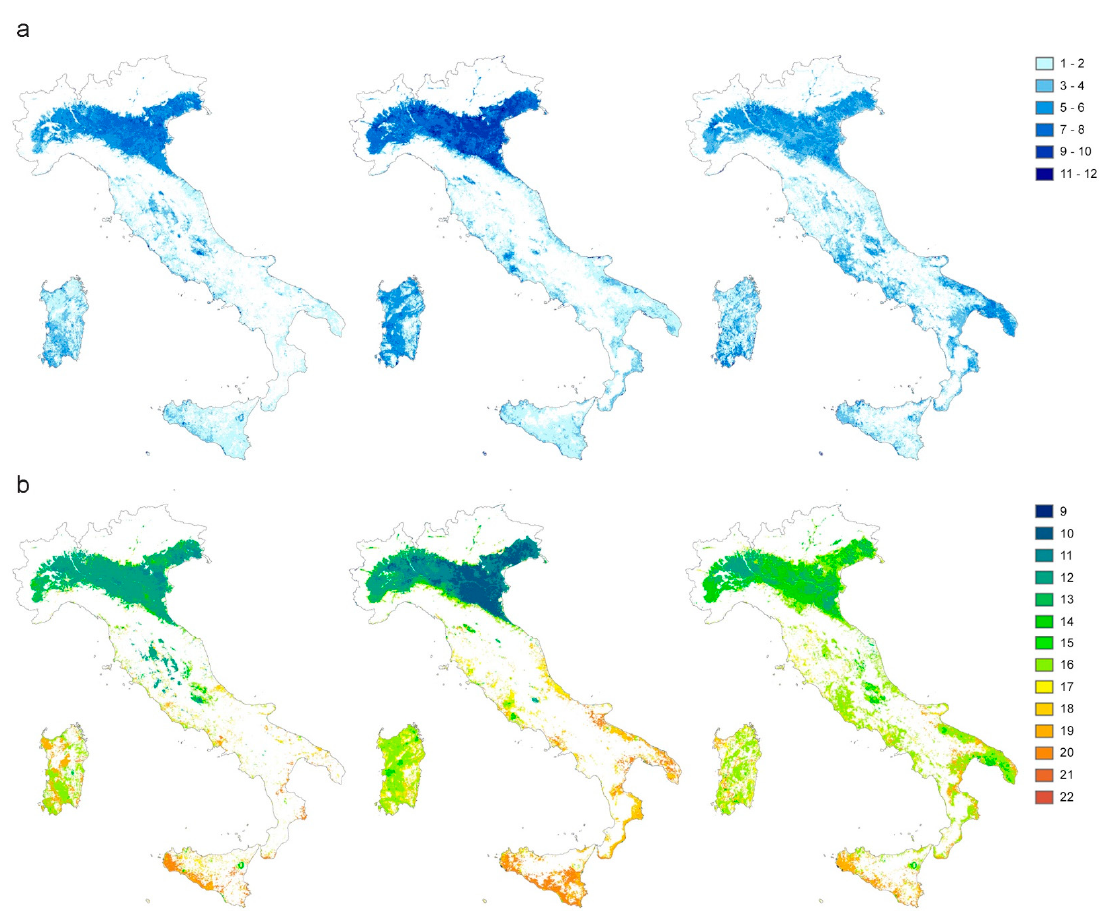
Figure 10. ( a ) Number of time steps (period of 16 days) with a probability of virus circulation > 0.5. ( b ) First time step in which the probability of virus circulation is > 0.5 for (at least) two consecutive 16-days